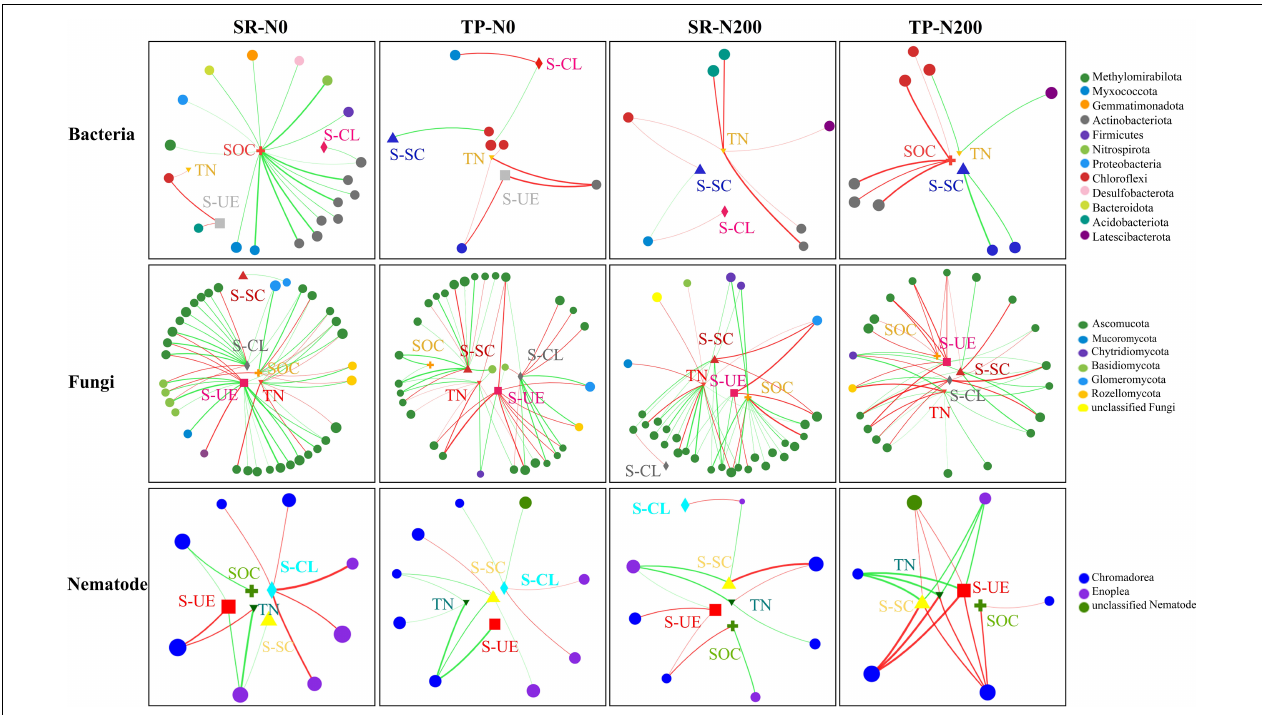
FIGURE 7 | Co-occurrence network diagram between bacterial and fungal taxa at the phyla level and nematode on the class level with soil fertility and enzymes under different treatments. Dot size indicates the value of relative abundances. Positive correlations are labeled with red lines and negative correlations are colored in green, thick lines are high correlations and little correlations have thin lines. Treatments: no nitrogen addition + straw addition (SR-N0), no nitrogen addition + traditional planting (TP-N0), no nitrogen addition + straw addition (SR-200), and traditional planting with nitrogen fertilizer application (TP-N200). TN, SOC, S-UE, S-CL, and S-SC represent total nitrogen content, soil organic carbon content, soil urease activity, soil sucrase activity, and soil cellulase